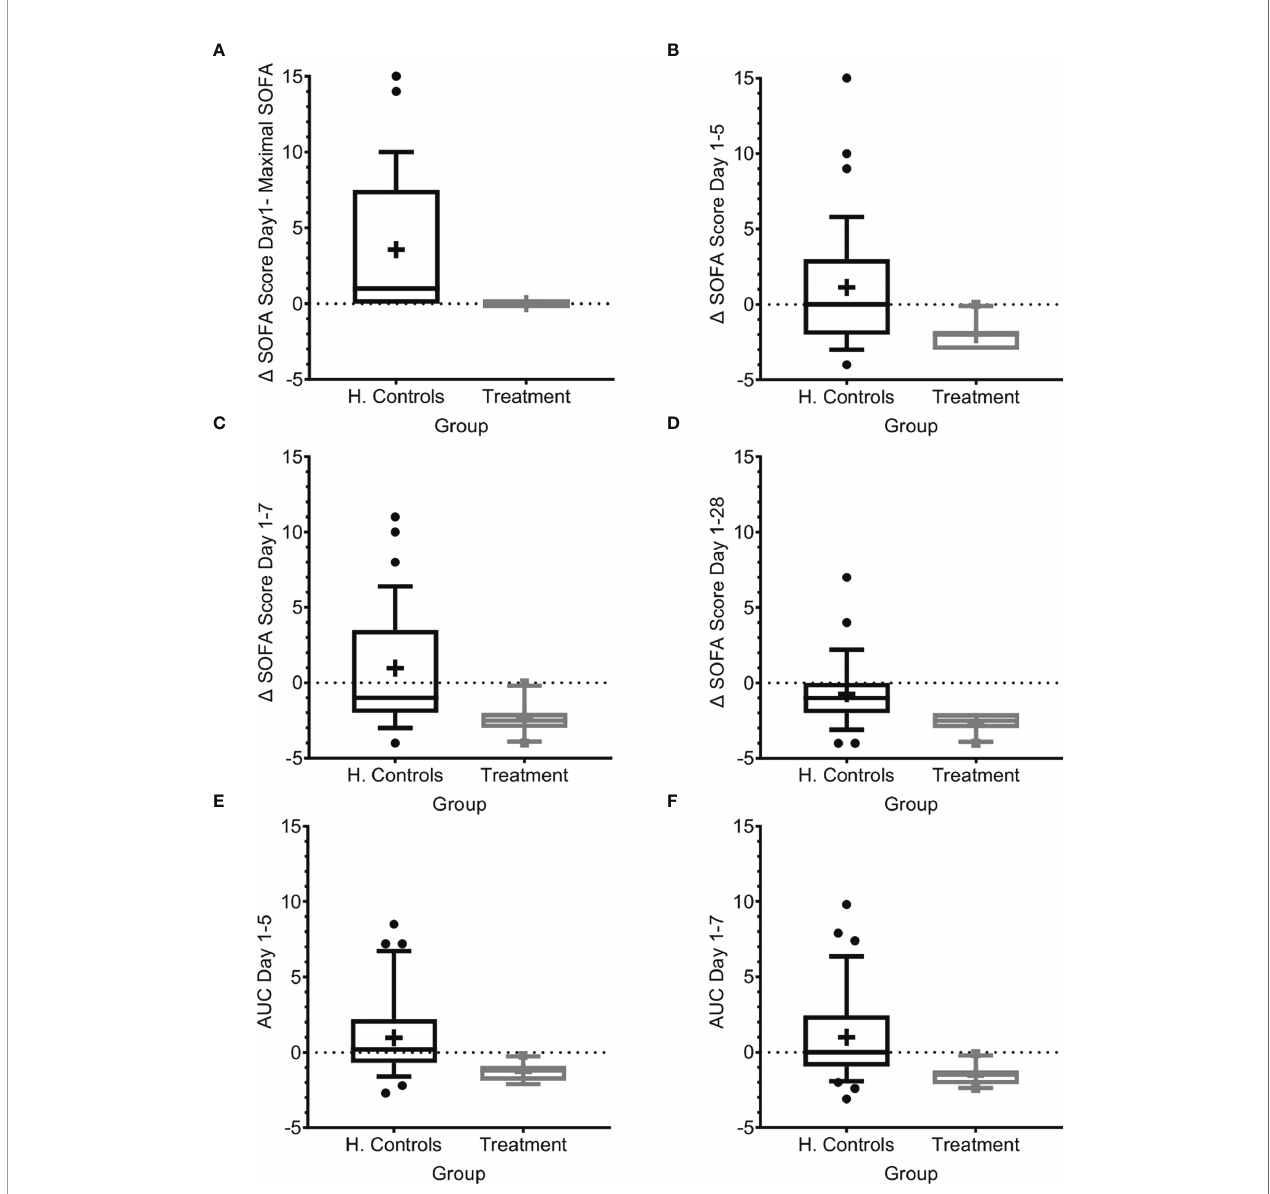
FIGURE 3 | SOFA score progression during sepsis. (A) SOFA score at presentation compared to maximal SOFA score. (B – D) Change in SOFA score before administration of Allocetra-OTS and day 5 (B) , day 7 (C) , and day 28 (D) . Average delta area under the curve (AUC) in the fi rst (E) fi ve days, and (F) seven days. Matched controls were selected from all patients admitted to ICU under the diagnosis of sepsis between 2014 – 2019 and were matched by gender, age ±7 years, SOFA score ±2 at presentation, and source of infection. Data is presented as the median within the interquartile range (IQR); mean values are marked with a ‘ + ’ sign; error bars represent the 10-90 percentile, with outliers